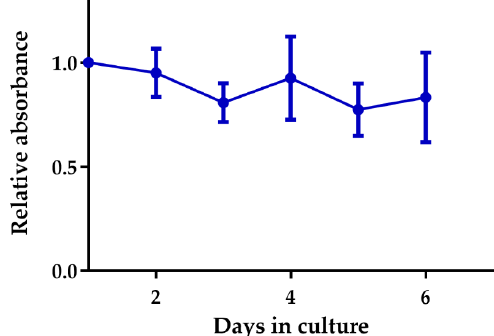
Figure 2. Metabolism of Cal33 tumor slices measured via PrestoBlue TM . Values were normalized to the first measurement at day 1 in culture. Cell viability stayed stable over the observed cultivation period of six days (mean with standard deviation (SD), n = 7).